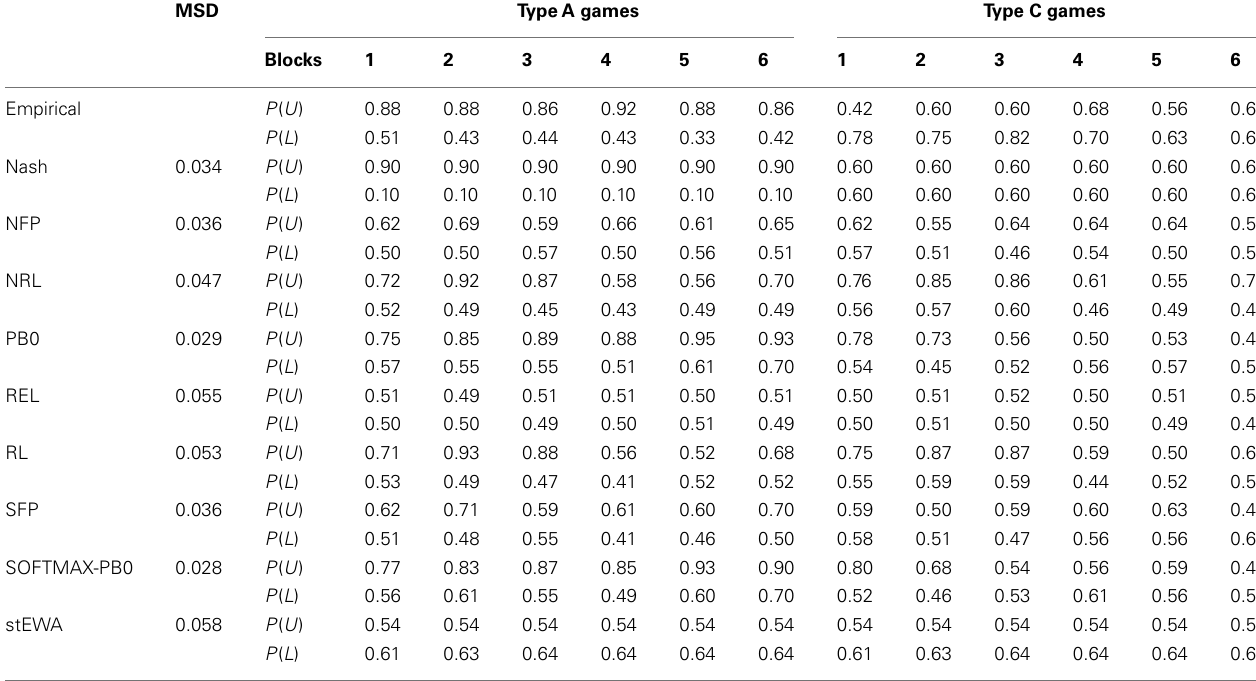
Table 4 | Predicted and observed choice frequencies in Experiment